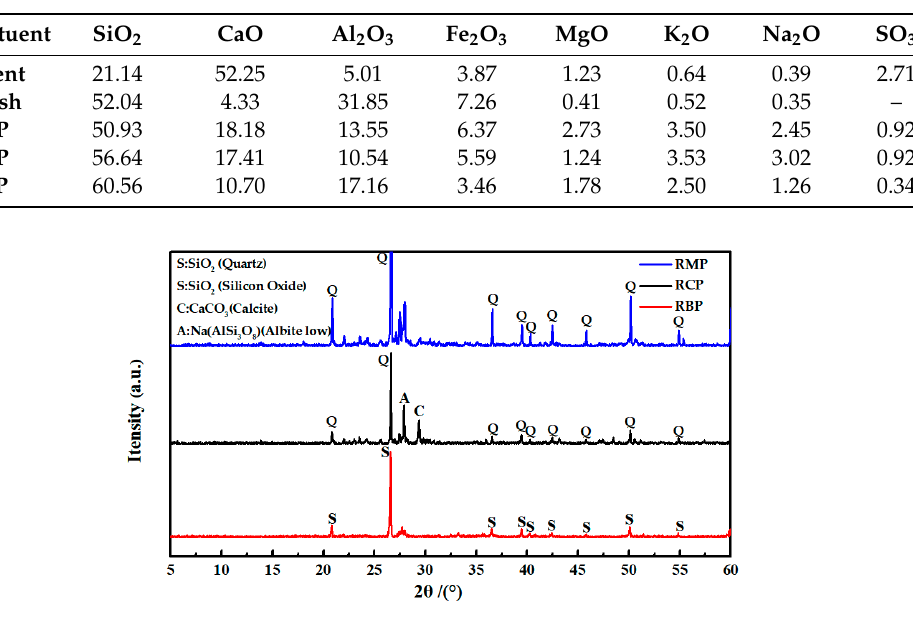
Table 6. Chemical composition of fly ash determined by XRF (w/%) .